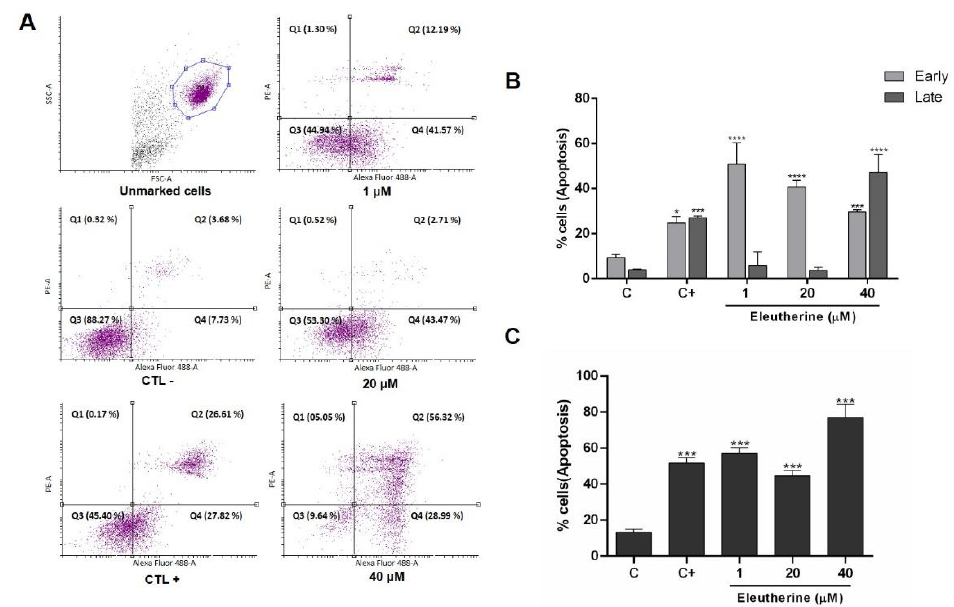
Figure 6. Eleutherine induces apoptosis in C6 cells. The cells were treated with eleutherine (1, 20, and 40 µM) for 24 h. ( A ) Cells were stained with annexin V – FITC and propidium iodide (PI) and subjected to flow cytometry analyses. Early apoptotic cells were in the Q4 quadrant and late apoptotic cells were in the Q2 quadrant. ( B ) Quantification of the percentage of early and late apoptotic C6 cells. ( C ) Quantification of the percentage of total apoptotic C6 cells. Here, * p < 0.05, *** p < 0.01, **** p < 0.0001 compared with untreated control (ANOVA, Tukey’s post hoc test); C, control; C+, positive control (camptothecin at 5 µM).